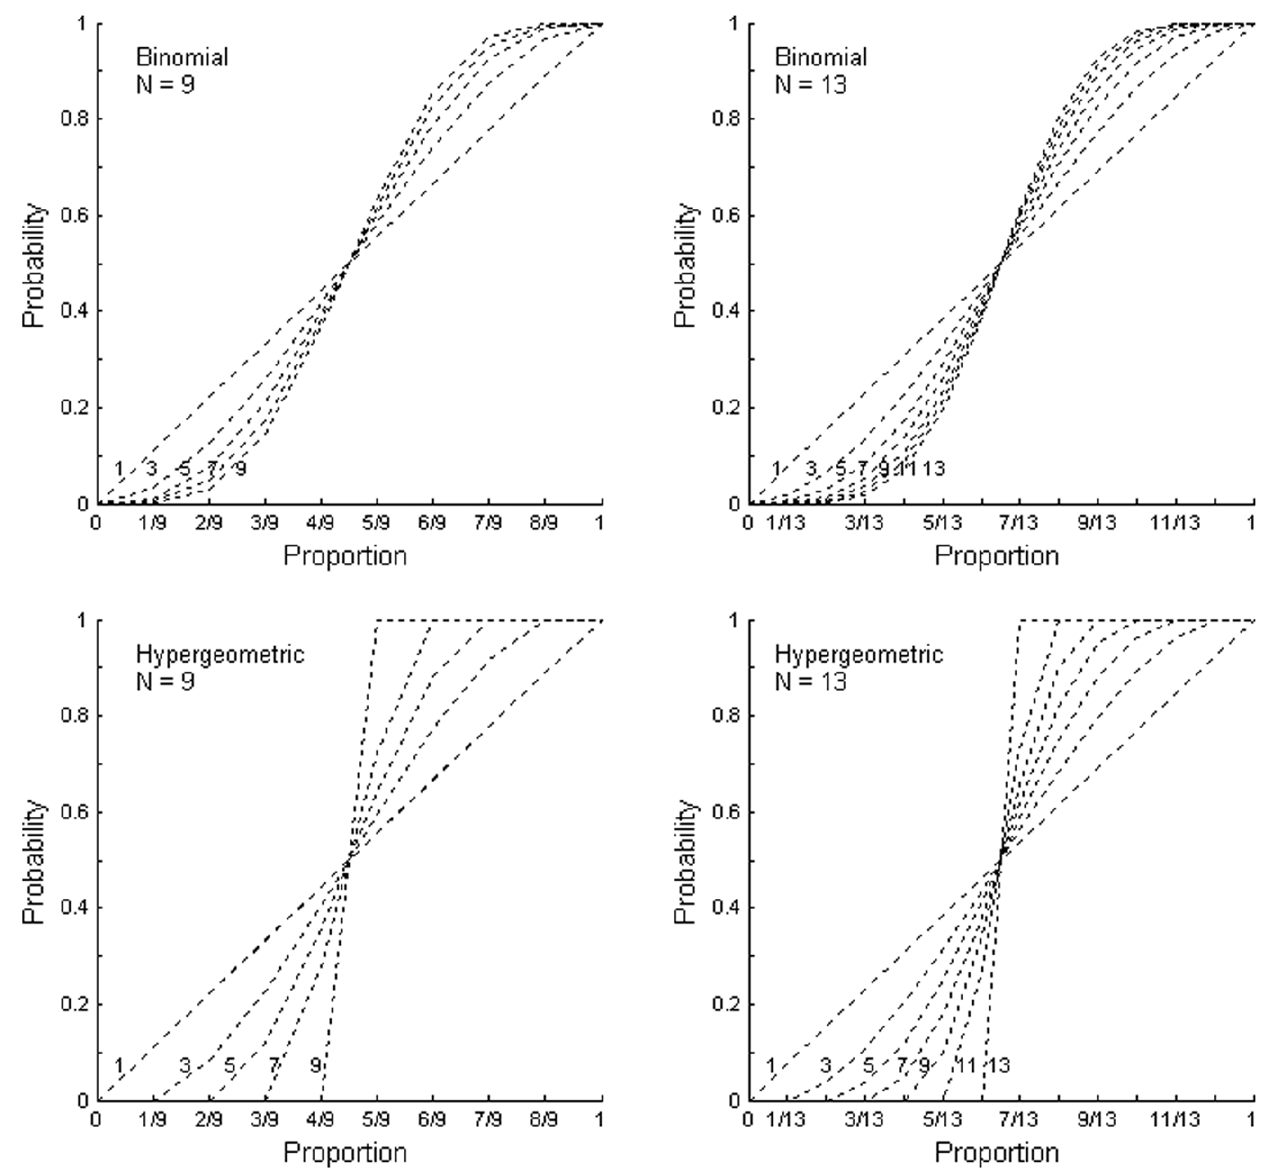
Figure 3. All possible theoretical models. All possible theoretical models corresponding to binomial (bin K ) or hypergeometric (hyp K ) distributions with the length of trials K